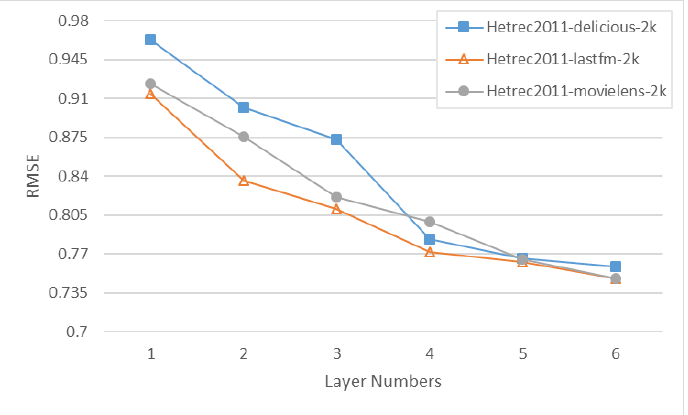
Figure 6. RMSE generated by models with different numbers of layers.